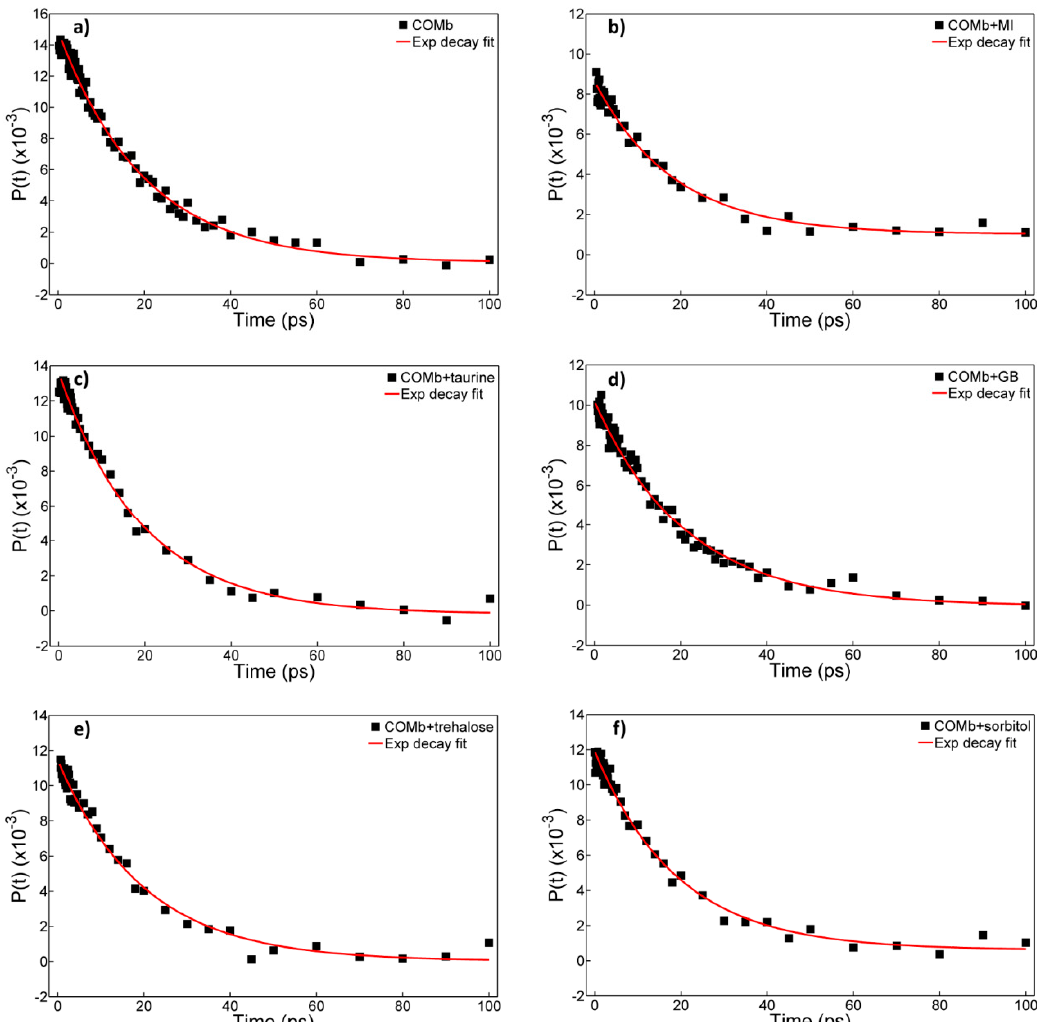
Figure 4. Slices of the pump-probe spectra of COMb in different osmolytes solutions for chosen frequencies of the positive peak and their single exponential decay fitting functions. “GB” stands for glycine-betaine, and “MI” for myo-inositol. ( a ) phosphate buffer in D 2 O, ( b ) 0.9 M myo-inositol, ( c ) 0.9 M taurine, ( d ) 3.0 M glycine betaine, ( e ) 1.5 M trehalose and ( f ) 3.0 M sorbitol.